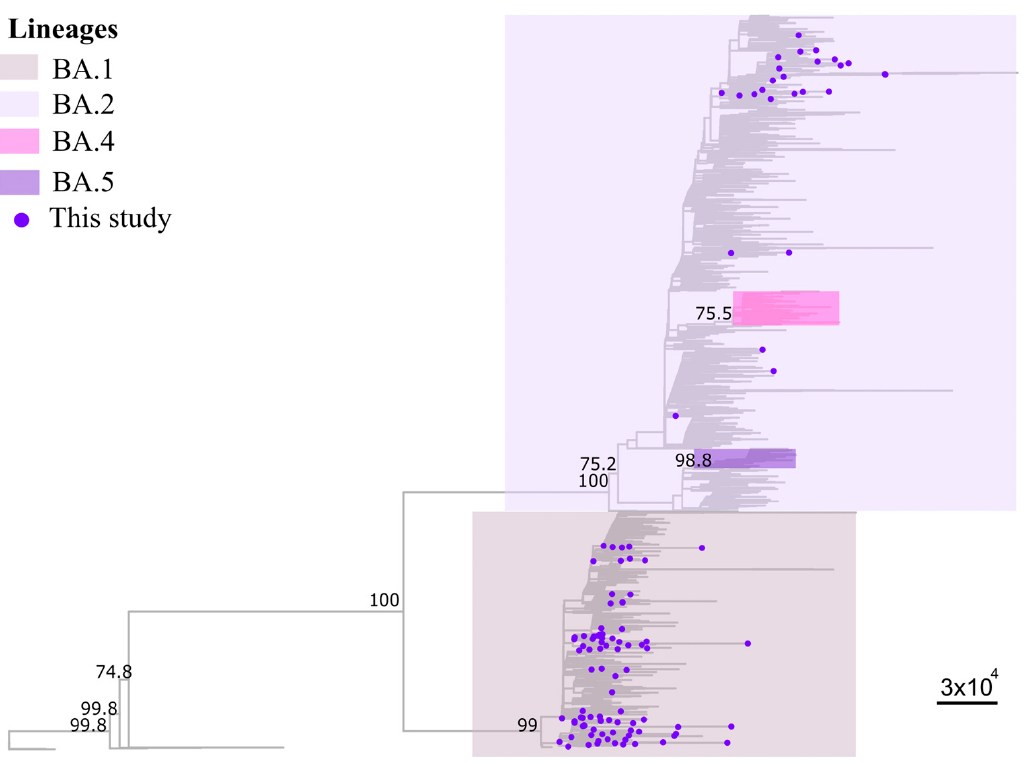
Figure 3. Phylogenetic reconstruction of SARS-CoV-2 during the fourth wave of SARS-CoV-2 in Brazil (epidemiological weeks 35/2021 to 09/2022). The dataset was constructed based on the genomes used by Nextclade as references for Omicron classification ( n = 1531). Maximum likelihood phylogenetic tree inferred from our dataset to confirm lineage classification. Purple-tipped shapes indicate genomes generated in our study ( n = 109). Node values correspond to bootstrap values. The clades corresponding to the variants BA.1, BA.2, BA.4, and BA.5 are highlighted in gray, lilac, pink, and purple, respectively.